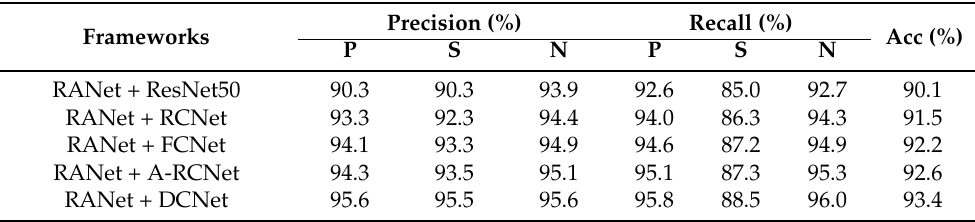
Table 5. Comparison of different frameworks in which RANet is combined with varying detection- classification